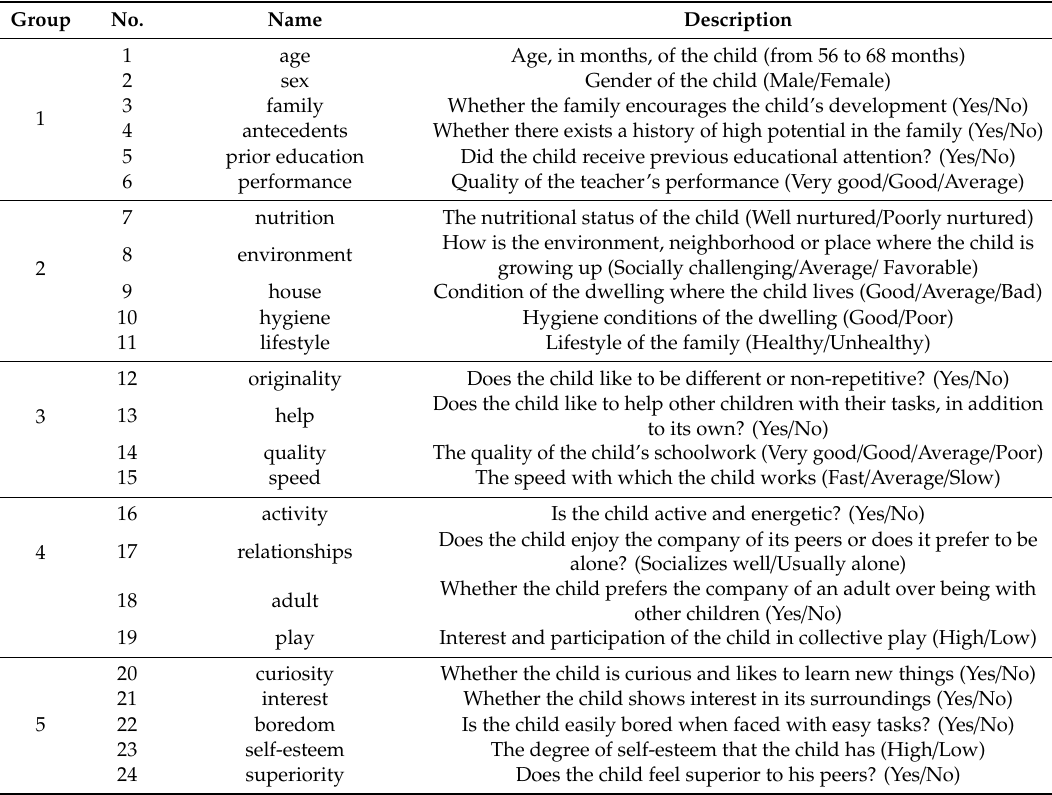
Table 1. Description of the attributes used in the process of automatic detection of kindergarten children with high development